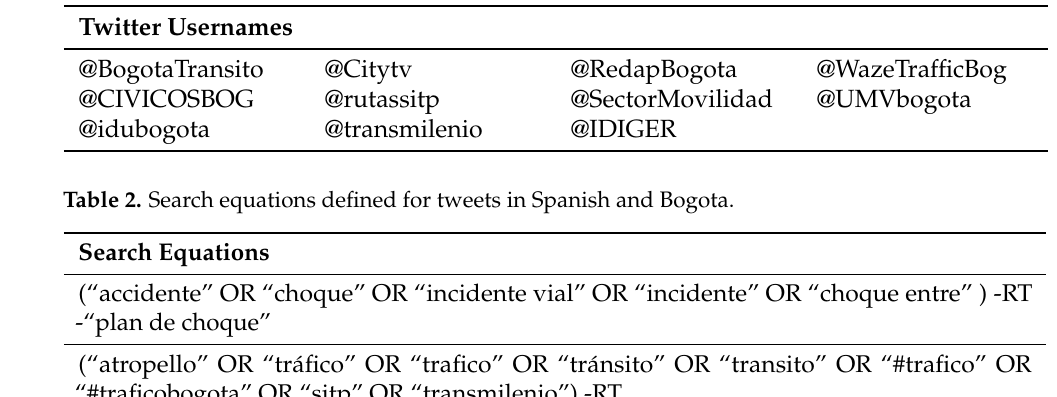
Table 1. Usernames of local government and mass media official accounts.